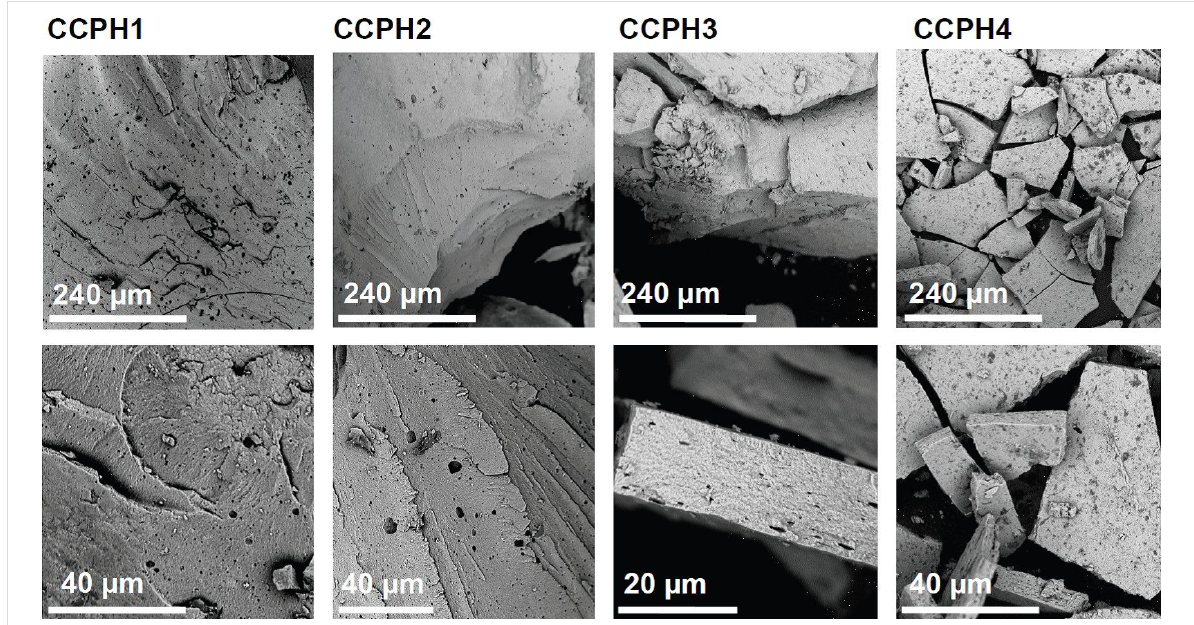
Figure 4: Low (top row) and high magnification (bottom row) SEM images of the hybrid materials prepared in the presence of GAA. Note the different scale bar in the lower row for CCPH3.